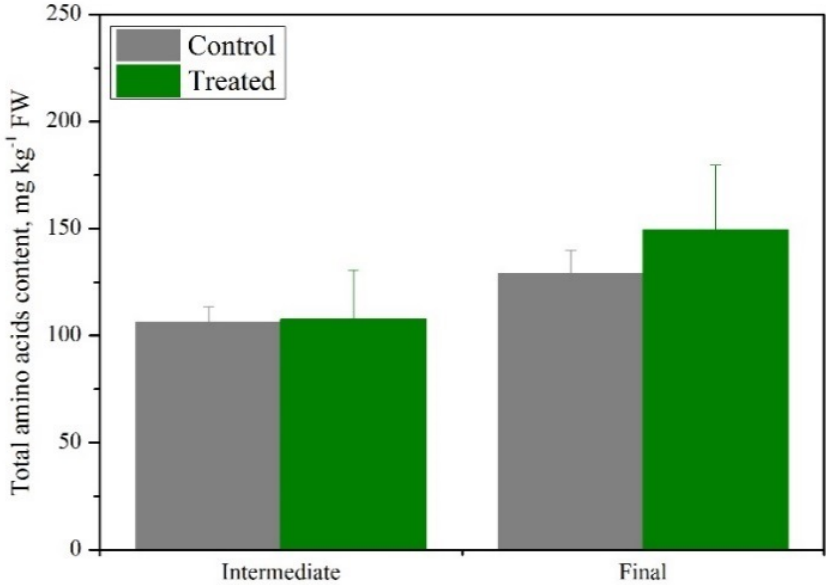
Figure 6. Total amino acid content of basil leaves grown as a secondary crop in the second experiment. The absence of letters indicates no statistically significant differences between treatments at both harvests ( p < 0.05). Values are expressed as mean ± standard deviation ( n = 5).